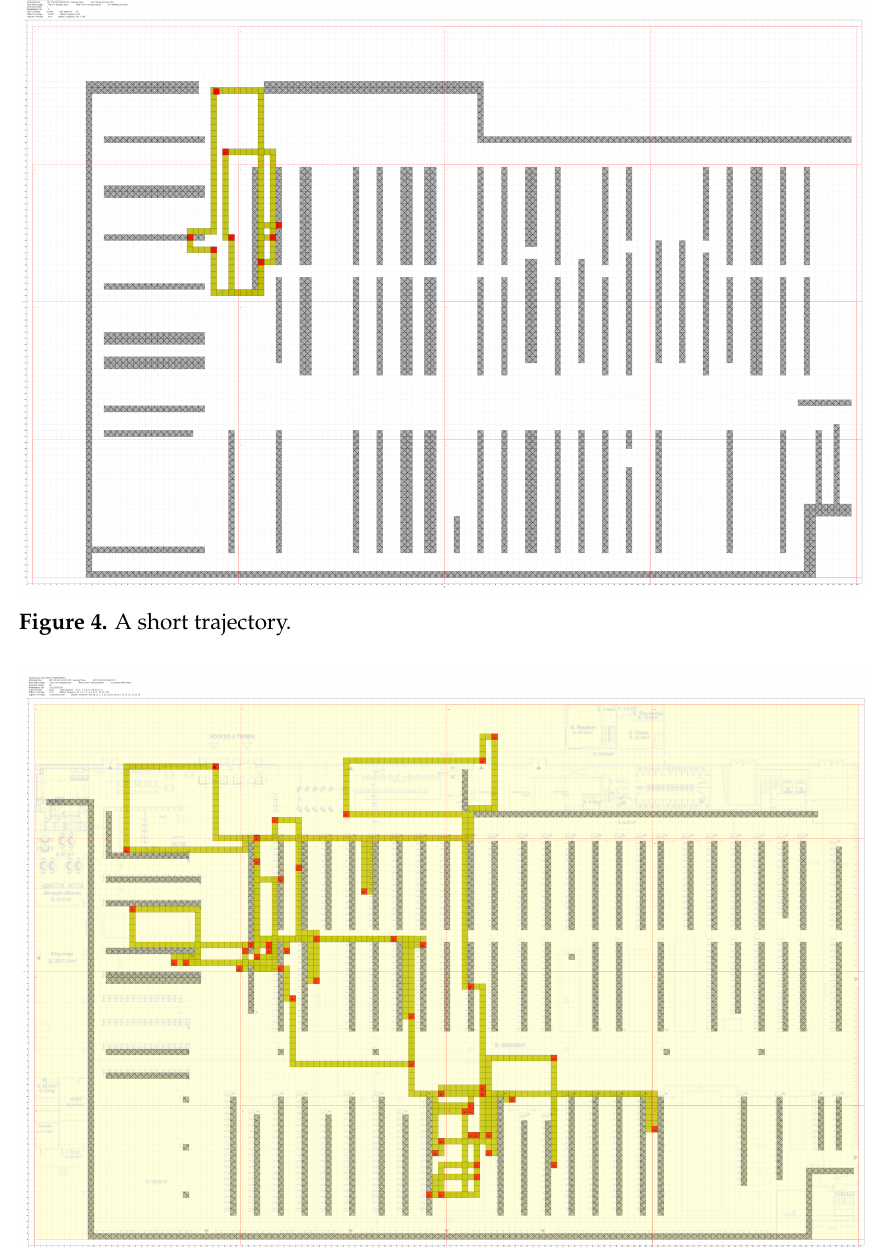
Figure 5. Long reconstructed